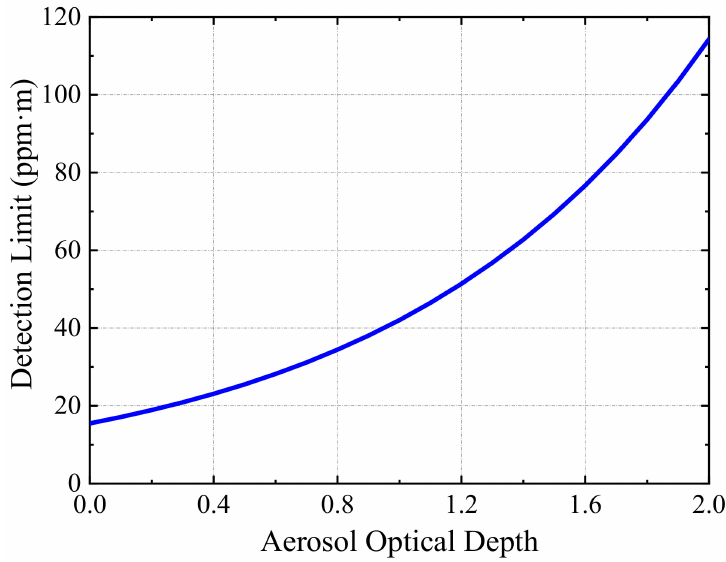
Figure 7. The detection limit of the SO 2 camera varying with aerosol optical